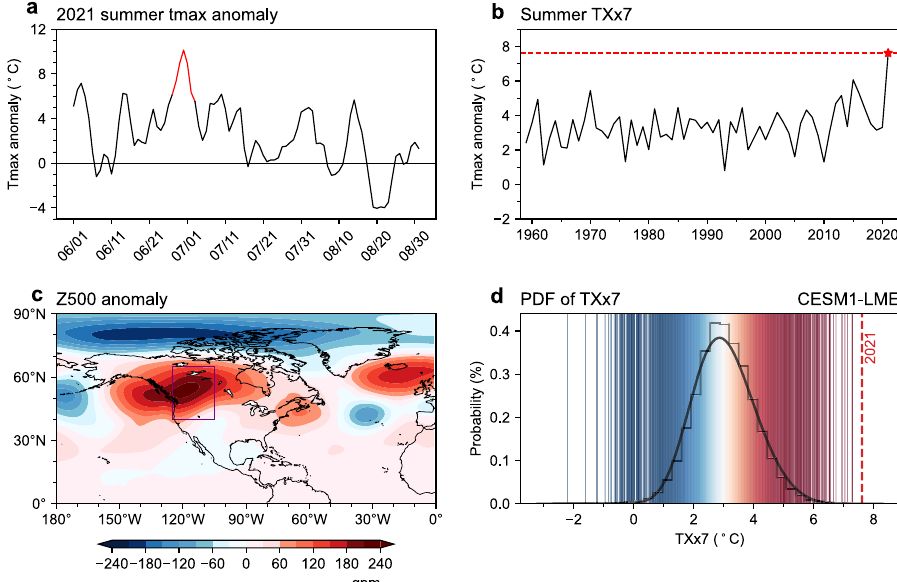
Fig. 1 | The characteristics of the heatwave of summer 2021 over the Western North America (WNA, 40° − 65°N, 125° − 105°W). a Evolution of maximum tem- peratureanomalies (relative to 1981-2010,unit: °C) insummer 2021 area-weighted averagedovertheWNA(purpleboxinFig.1c). b Evolutionoftheanomaliesof TXx7 (unit: °C)area-weightedaveragedovertheWNAduring1959 – 2021. TXx7 isde fi ned astheannualsummer(June – August)maximaofthe7-dayrunningmeanofthedaily maximum temperature anomaly area-weighted averaged over the WNA. The red